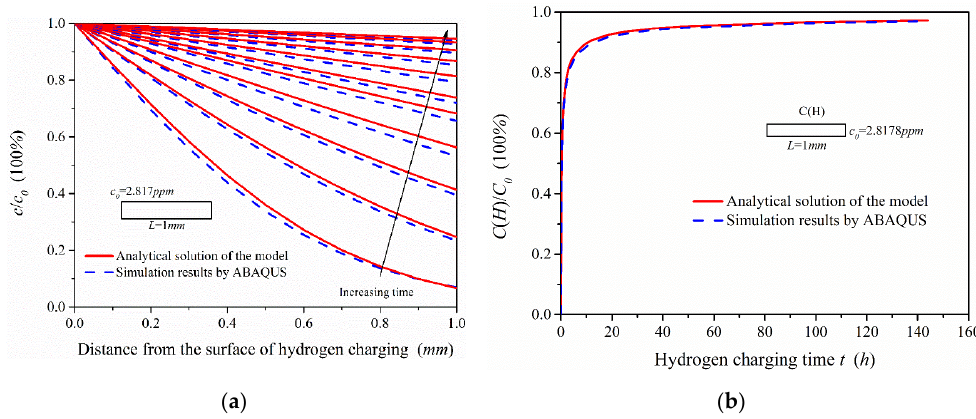
Figure 11. Comparison of simulation results and analytical solutions of the model: ( a ) Hydrogen concentration distribution in the 1-mm-thick sample under different hydrogen charging time; ( b ) the change trend of hydrogen content in the 1-mm-thick model with hydrogen charging time.